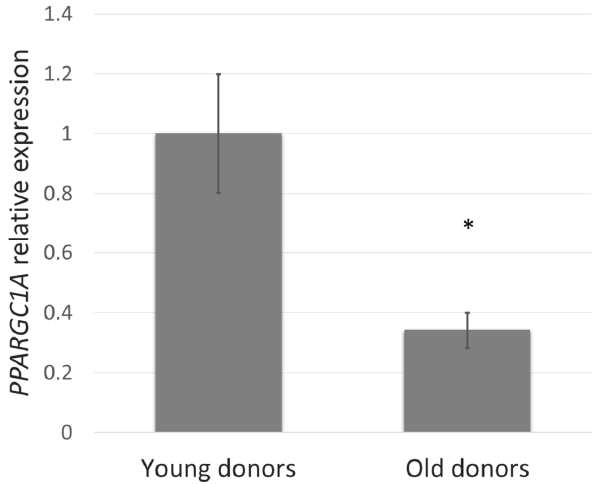
Figure 1. PPARGC1A gene expression in normal human dermal fibroblasts (NHDF) cells from